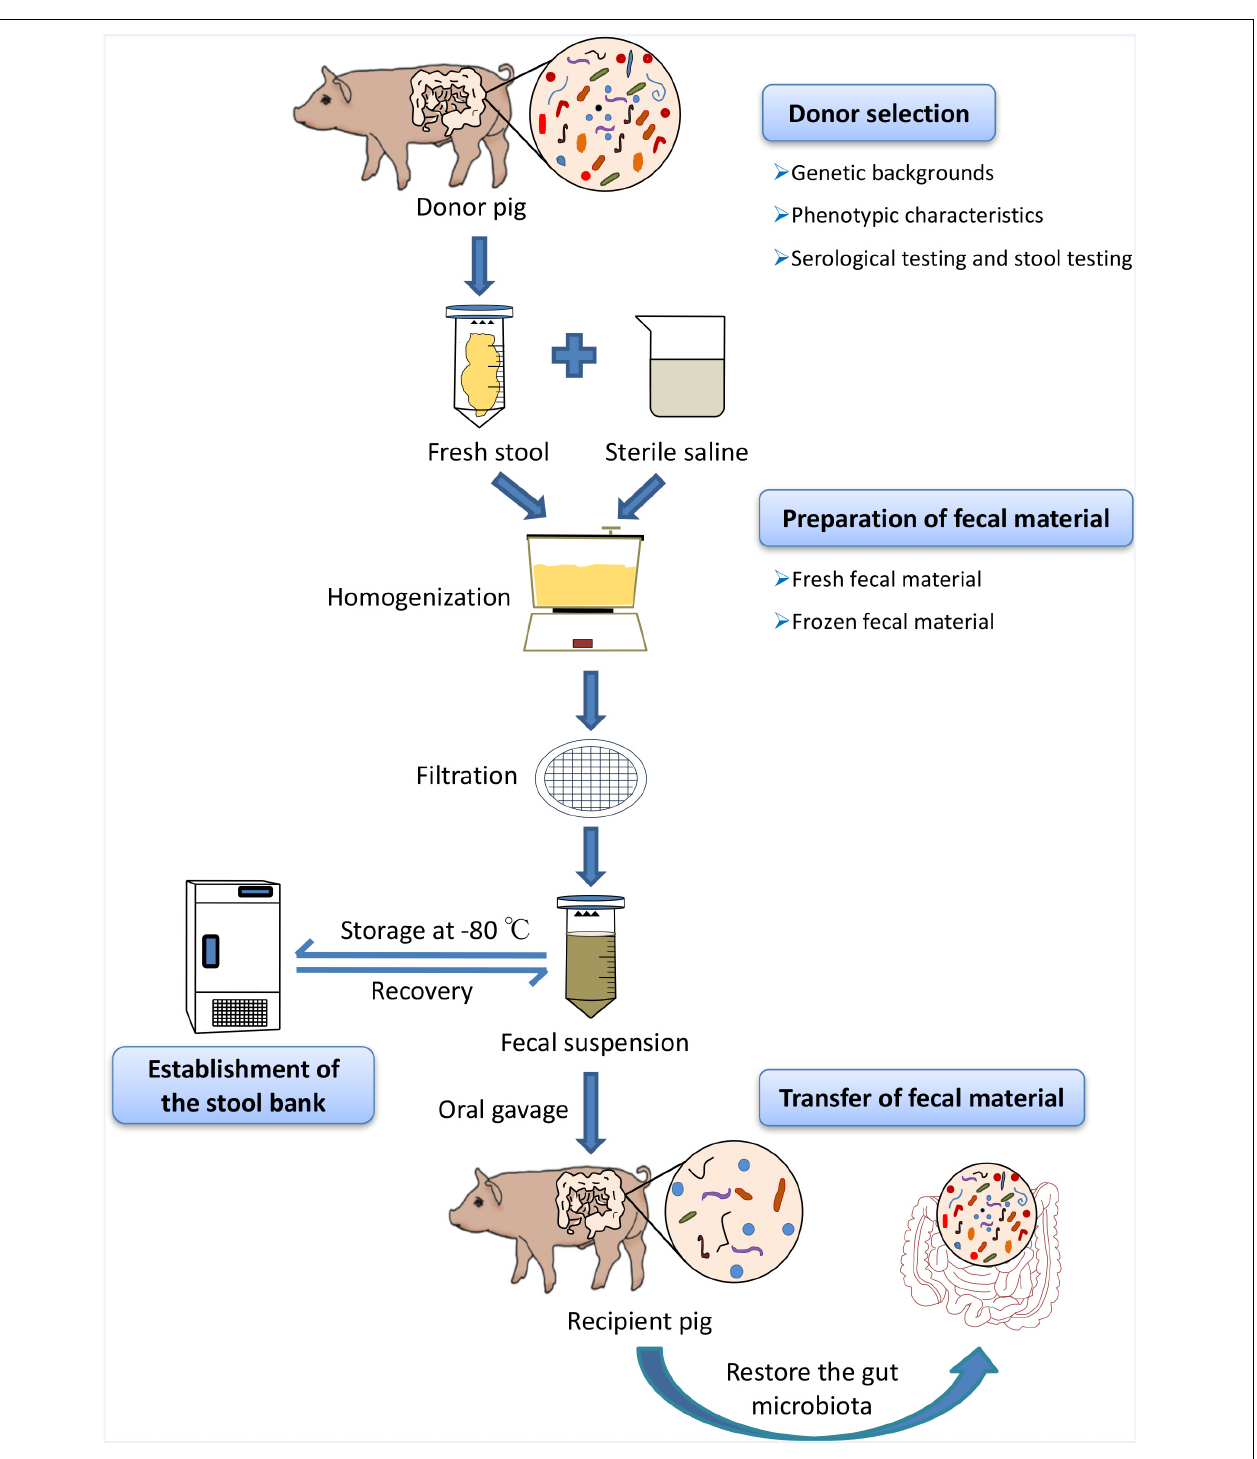
FIGURE 1 | Schematic workflow of fecal microbiota transplantation (FMT) in pigs. At first, optimal donors should be selected to ensure the efficacy of porcine FMT and reduce the risks of transmitting infectious diseases during the transfer of fecal suspension via strict genetic backgrounds investigation, phenotypic characteristics, and serological test and stool testing. Fresh feces from healthy donor pigs were homogenized with sterile saline (0.9% NaCl) in blender and the stool materials should be diluted 3–5 times with large volumes of the buffer solution. The slurry was then filtered through sterile sieves and the suspension is either transferred to the recipients or mixed with 10% sterile glycerol to store at – 80 ◦ C immediately. When there is the need for porcine FMT, the frozen fecal suspension should be thawed at 37 ◦ C (water bath).